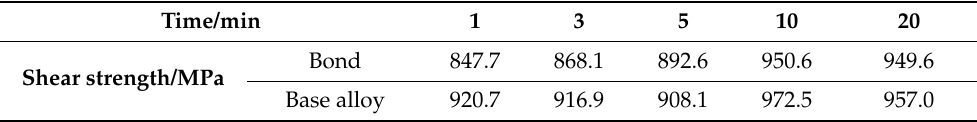
Table 4. Shear strength of the bond and base